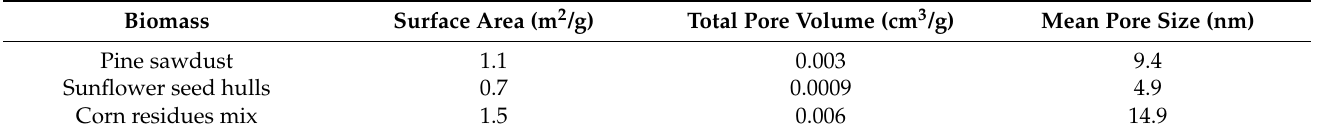
Table 1. BET analysis results of surface area, total pore volume and mean pore size for biomass residues.